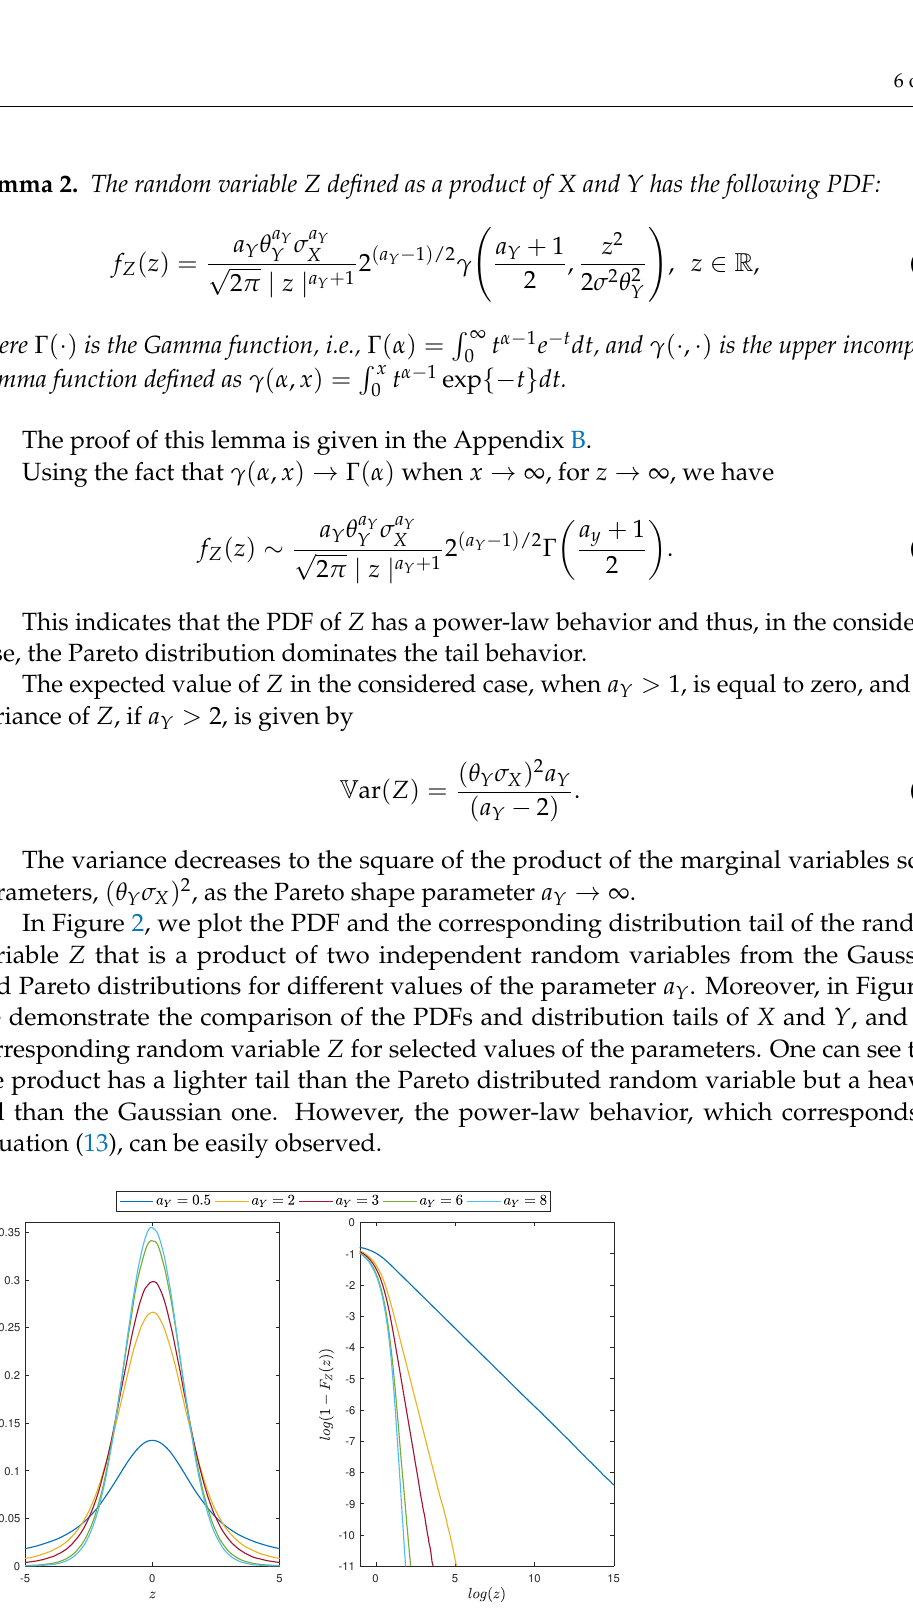
Figure 2. Distribution of the product of two independent random variables from the Gaussian and Pareto distribution with µ X = 0 and σ X = θ Y = 1 and different values of the a Y parameter. ( Left panel ): the PDF of the random variable Z . ( Right panel ): the distribution tail for the random variable Z (in log-log